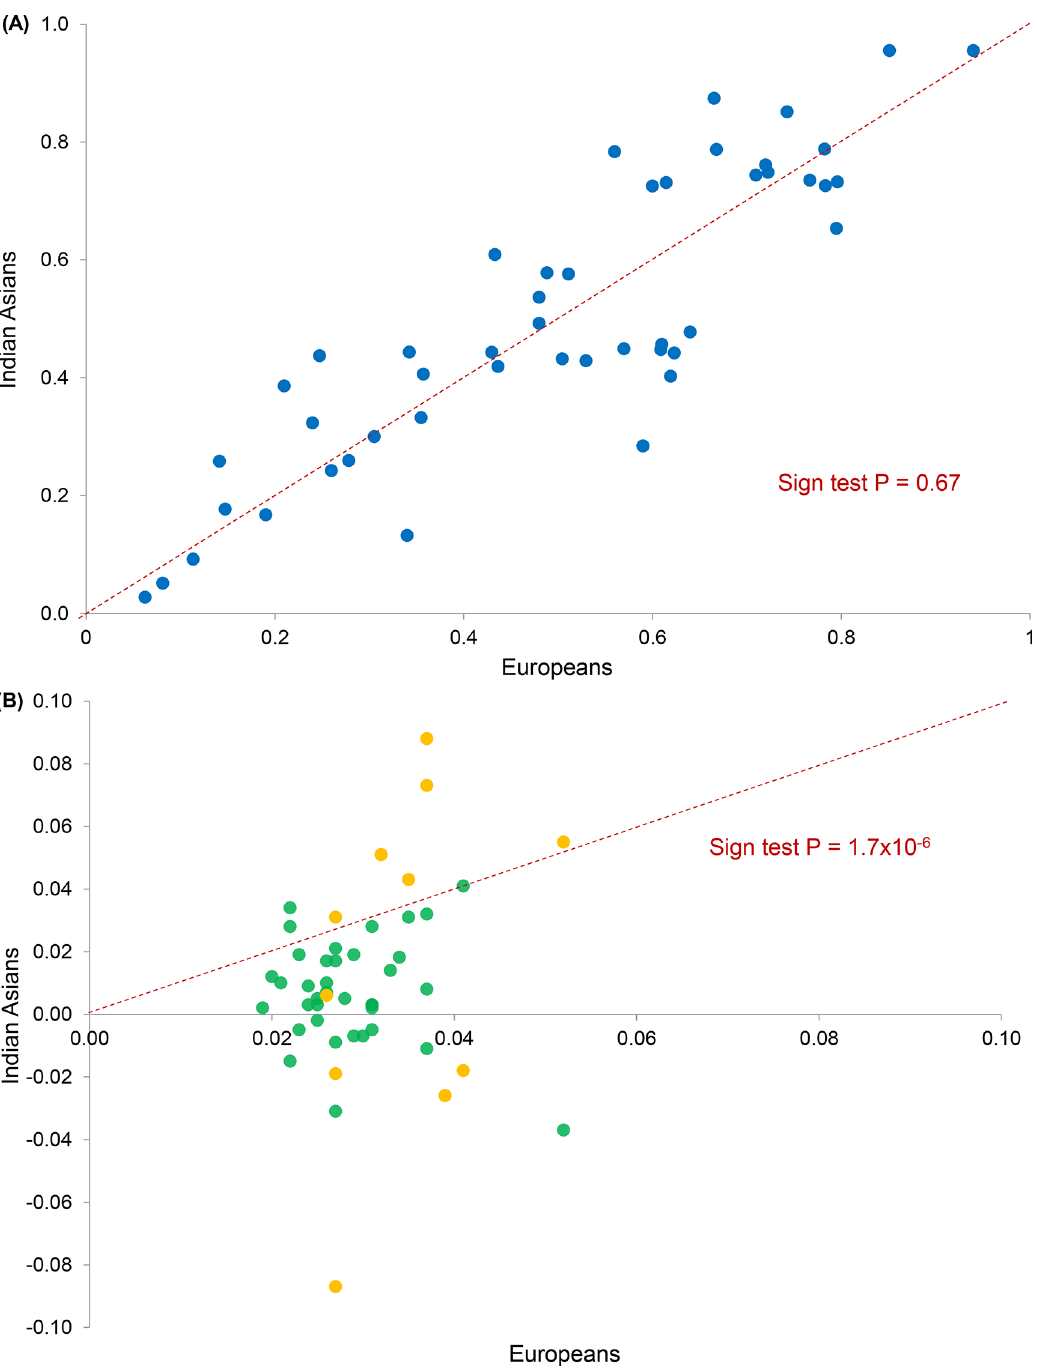
Fig 3. Known WHR SNPs. (A) Comparison of risk allele frequencies in South Asians (N = 10,318) and Europeans (reported). (B) Comparison of effect sizes ( β WHR) in South Asians and Europeans. Green – men and women combined (37 SNPs in South Asians (N = 10,318) and Europeans (reported)); orange – women alone (11 SNPs in South Asians (N = 1,463) and Europeans